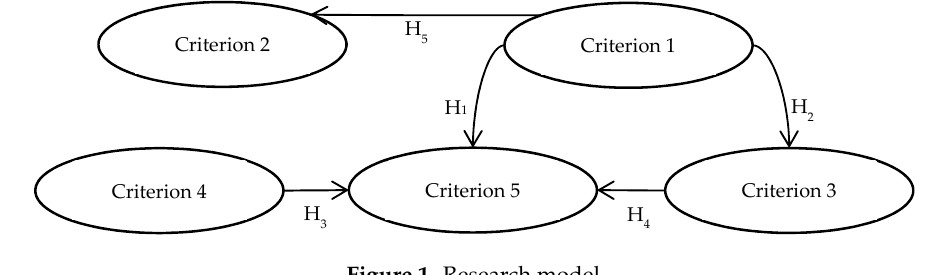
Figure 1. Research Figure 1. Research model.